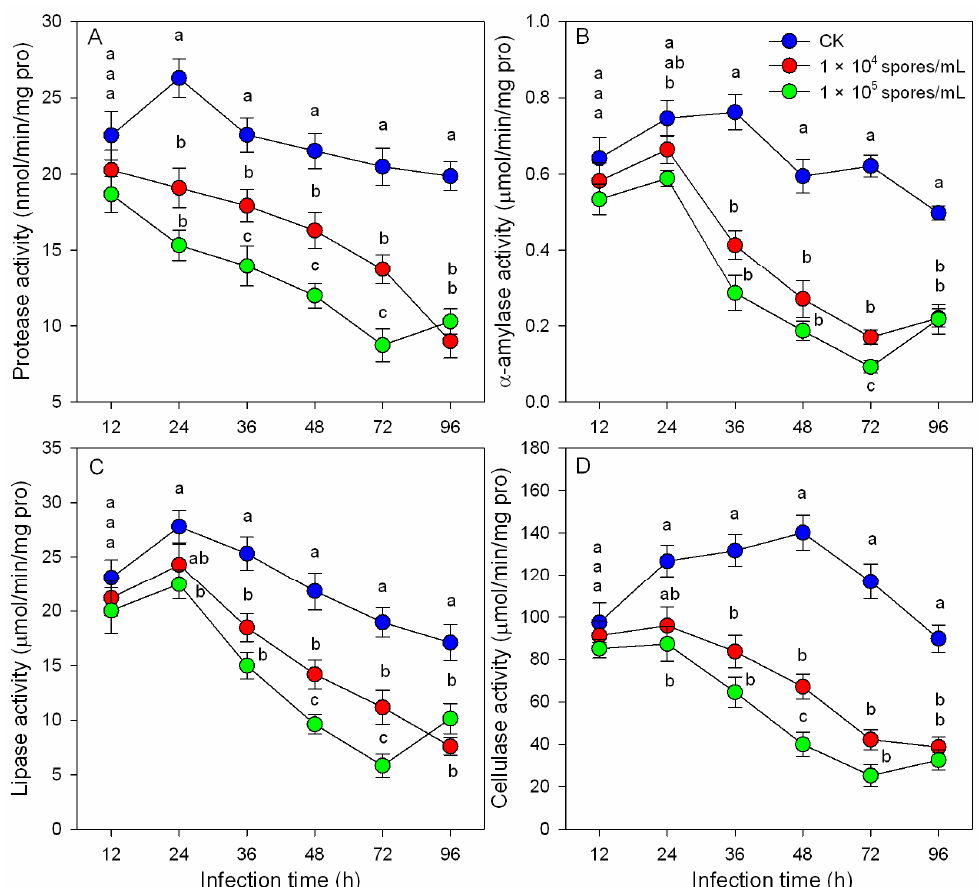
Figure 2. Digestive enzyme activities (( A ): protease, ( B ): α -amylase, ( C ): lipase, and ( D ): cellulase) of B. odoriphaga larvae after infection with M. hiemalis spores. Data in the figure are the mean ± SE. Different letters over the same column indicate significant differences between different spore con- centration treatments at the p < 0.05 level by one-way ANOVA. Different letters (a and b) over the same column indicate significant differences between different spore concentration treatments at the p < 0.05 level as indicated by one-way ANOVA.